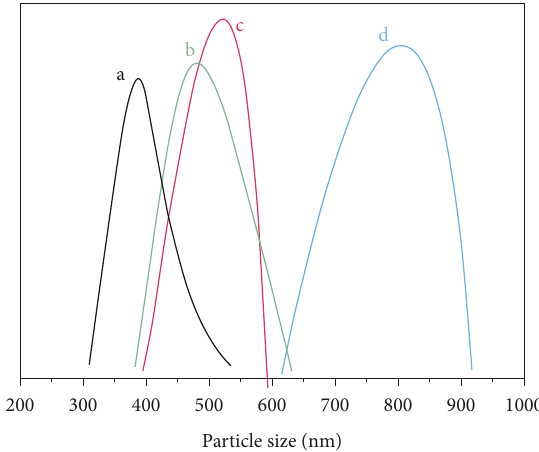
distribution. (a) 0.06M H + , 0.01M K 3 [Fe(CN) 6 ]; (b) 0.12M H + , 0.01M K 3 [Fe(CN) 6 ]; (c) 0.06 M H + , 0.05 M K 3 [Fe(CN) 6 ]; (d) 0.06M H + , 0.10M K 3 [Fe(CN) 6